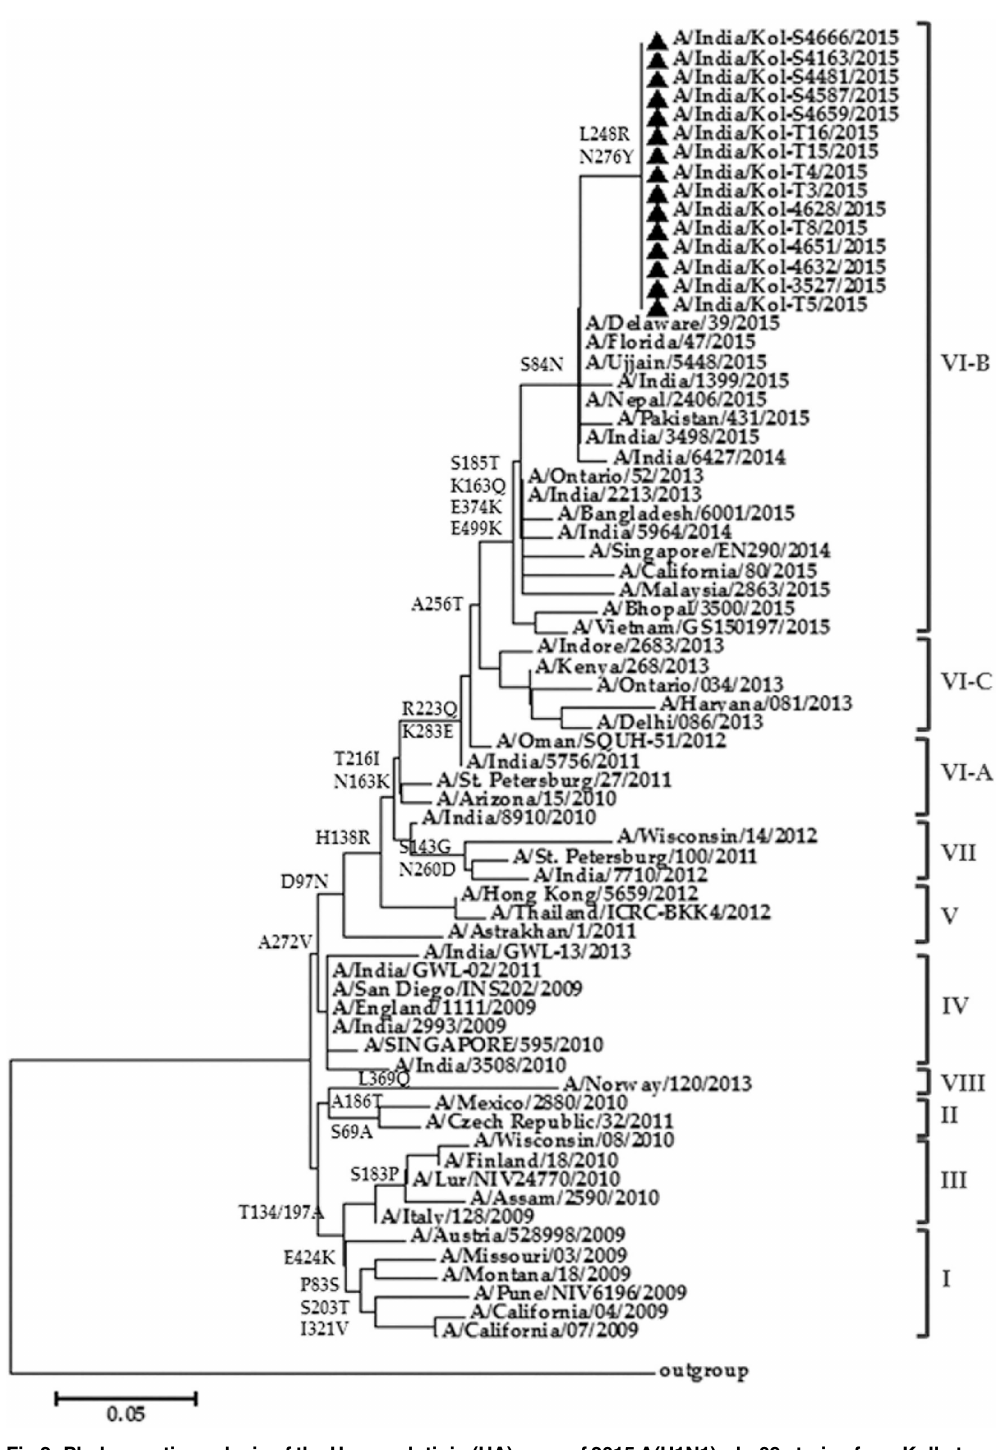
Fig 2. Phylogenetic analysis of the Hemagglutinin (HA) gene of 2015 A(H1N1)pdm09 strains from Kolkata, India (designated with black triangle). The tree was constructed with globallydistributed A(H1N1)pdm09 HA amino acid sequencesrepresenting all genogroups from different timeline and lineages. Amino acid substitutions are depicted on the major branchesat the nodes.